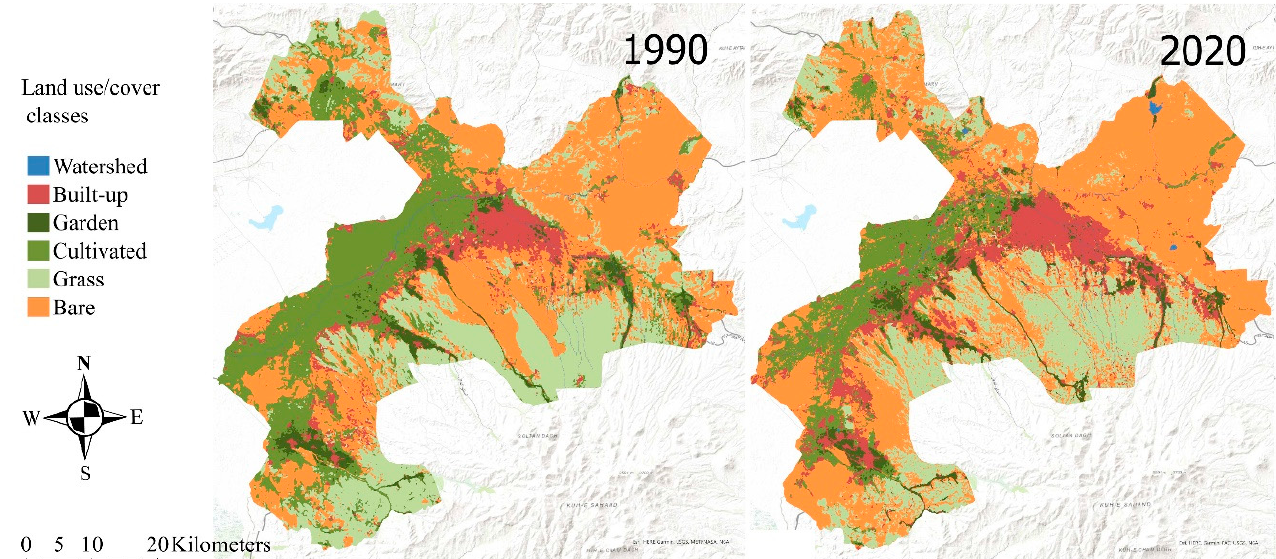
Figure 4. Classified land use map.